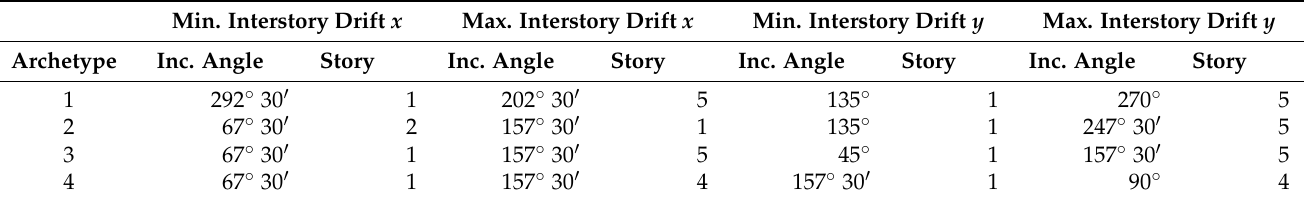
Table 5. Summary of the angles of incidence that produce the maximum and minimum drifts on the archetypes in the x and y directions.